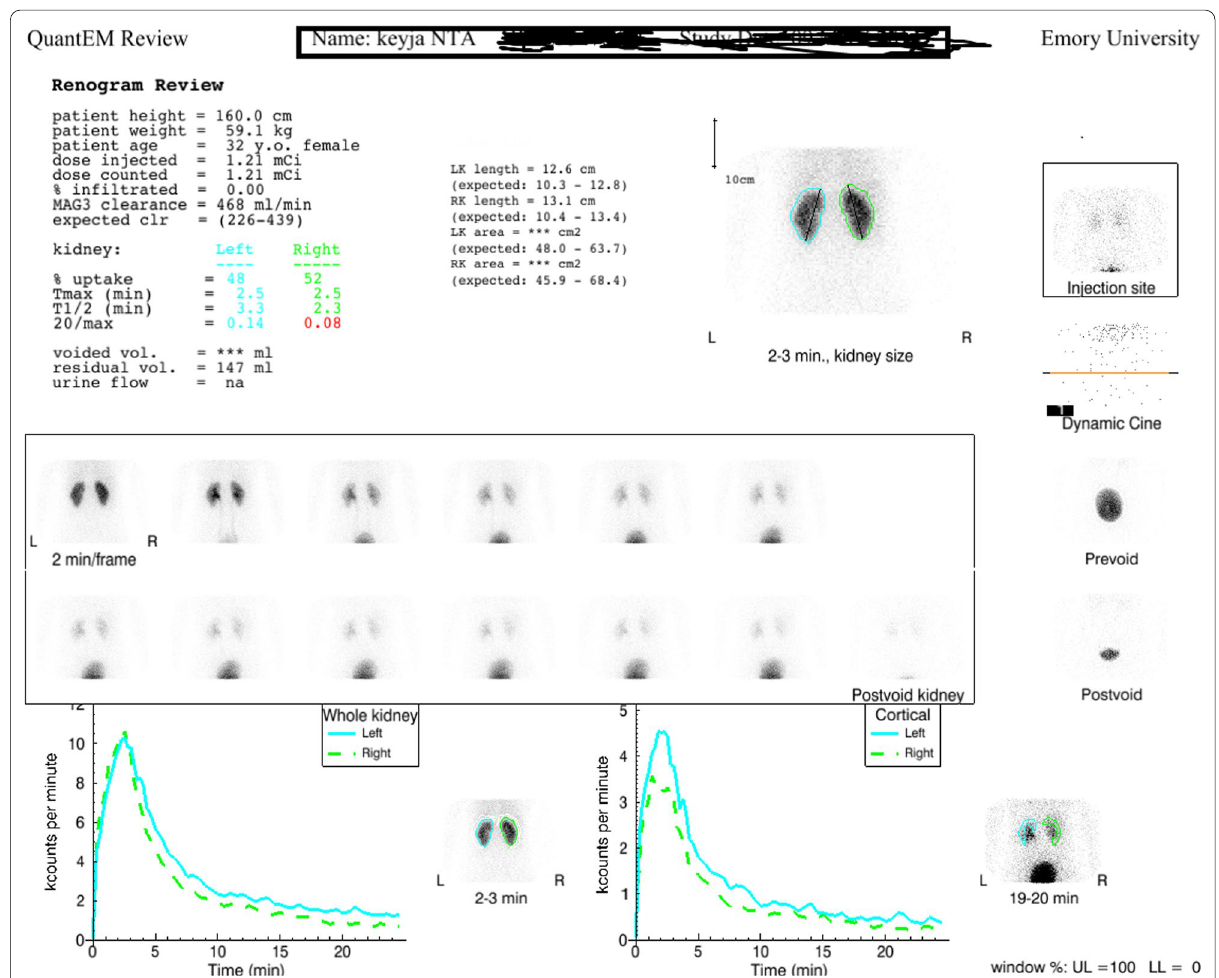
Fig. 2 Subject 3: Two minute sequential images following the administration of [ 99m Tc]Tc-MAG3 (338 MBq) and [ 99m Tc]Tc(CO) 3 (NTA) (46 MBq)with the corresponding renogram curves. The T1/2 of the left kidney MAG3 was 5.5 min compared to 3.3 min for